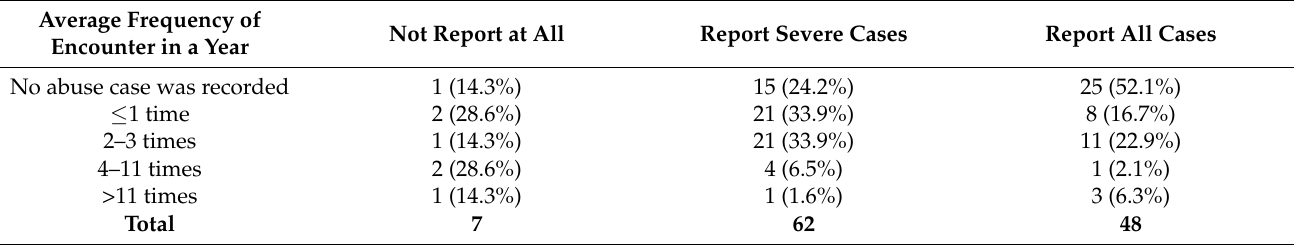
Table 14. Comparisons between the suspected physical animal abuse cases encountered by veterinar- ians and their attitude toward reporting suspected animal